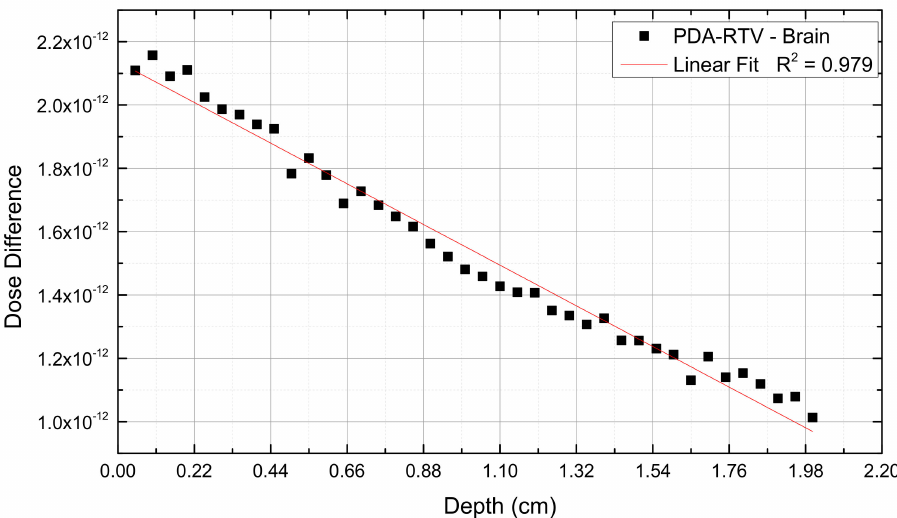
Figure 11. Dose-difference (Gy per incident photons) plot between the brain and the PDA-RTV dosimeter achieved by the subtraction of both